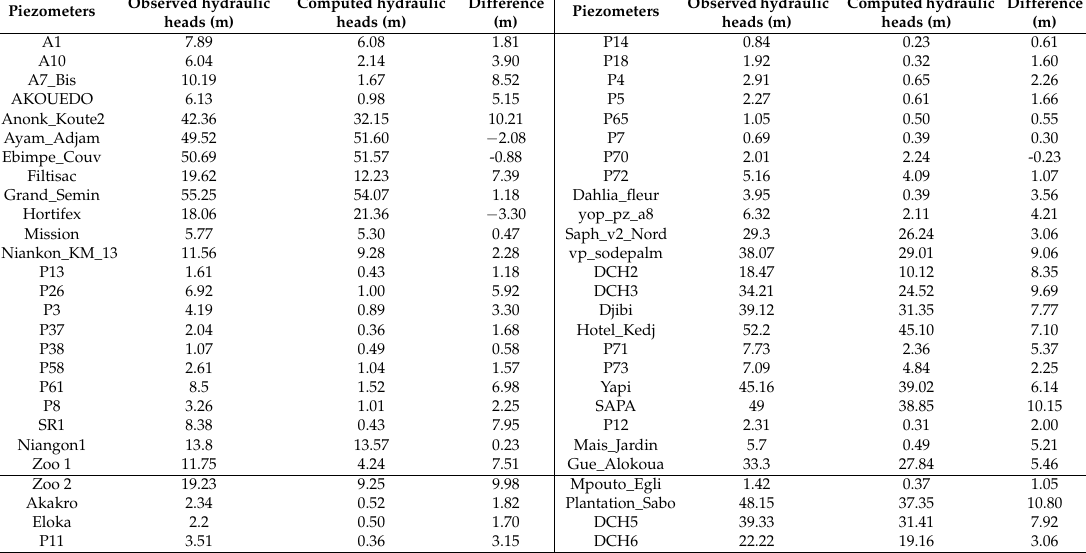
Table A2. Difference between the observed and computed hydraulic heads in